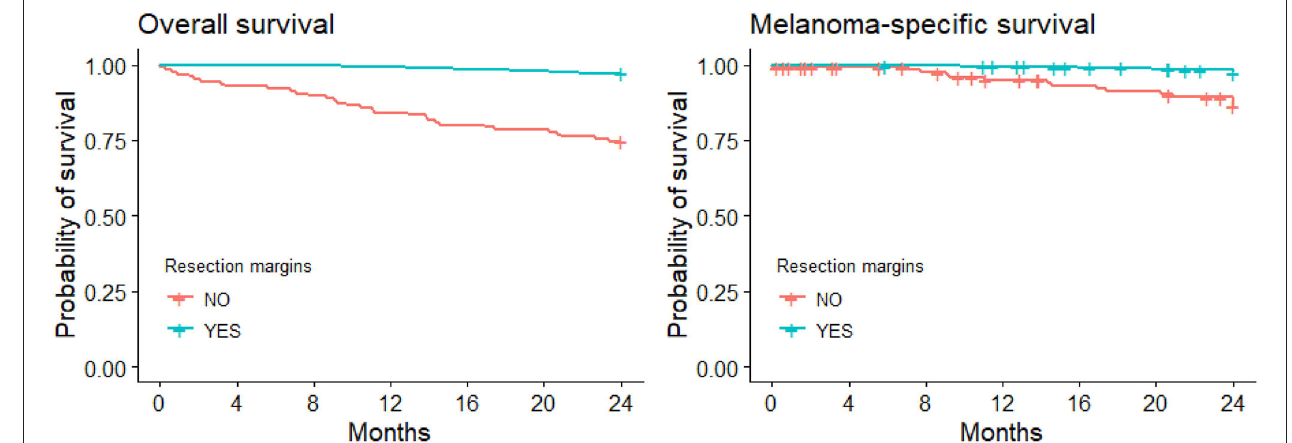
FIGURE 1 | Kaplan-Meier curves for overall and melanoma-specific survival with/without wide local excision.